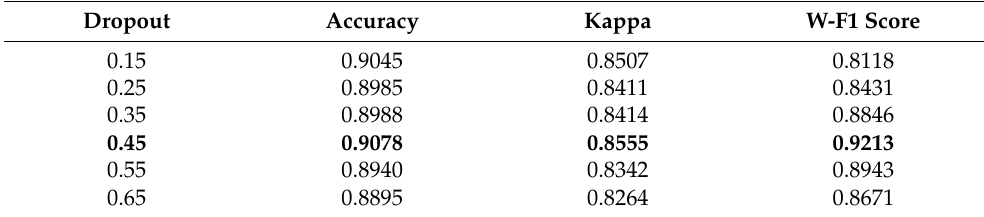
Table 4. Selection of dropout